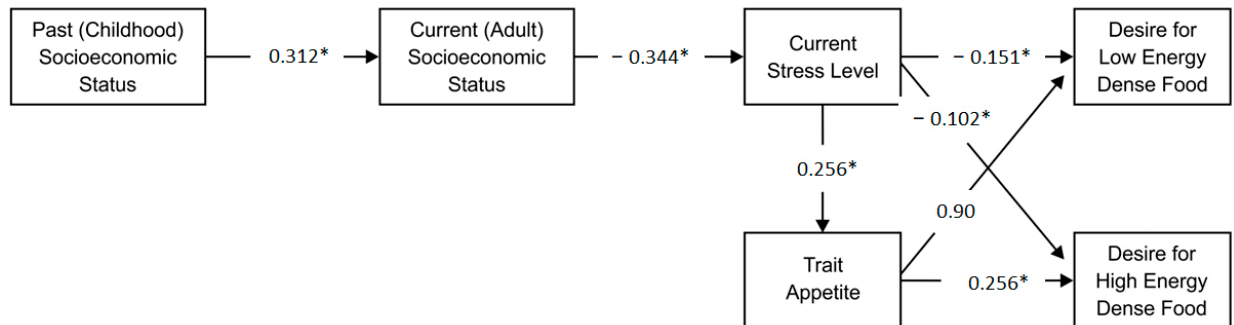
Figure 1. Path analysis for low and high-energy-dense food preferences. * Denotes path is significant. Footnote: “Path coefficients” are partial regression coefficients. Partial regression coefficients remove the effects of correlated influences (or the effect of two independent variables on a dependent variable). For example, stress (IV) and low SES (IV) are all correlated with obesity (DV). Each of the IVs are called ‘partial’ coefficients because they remove the effect of the additional IV variables.